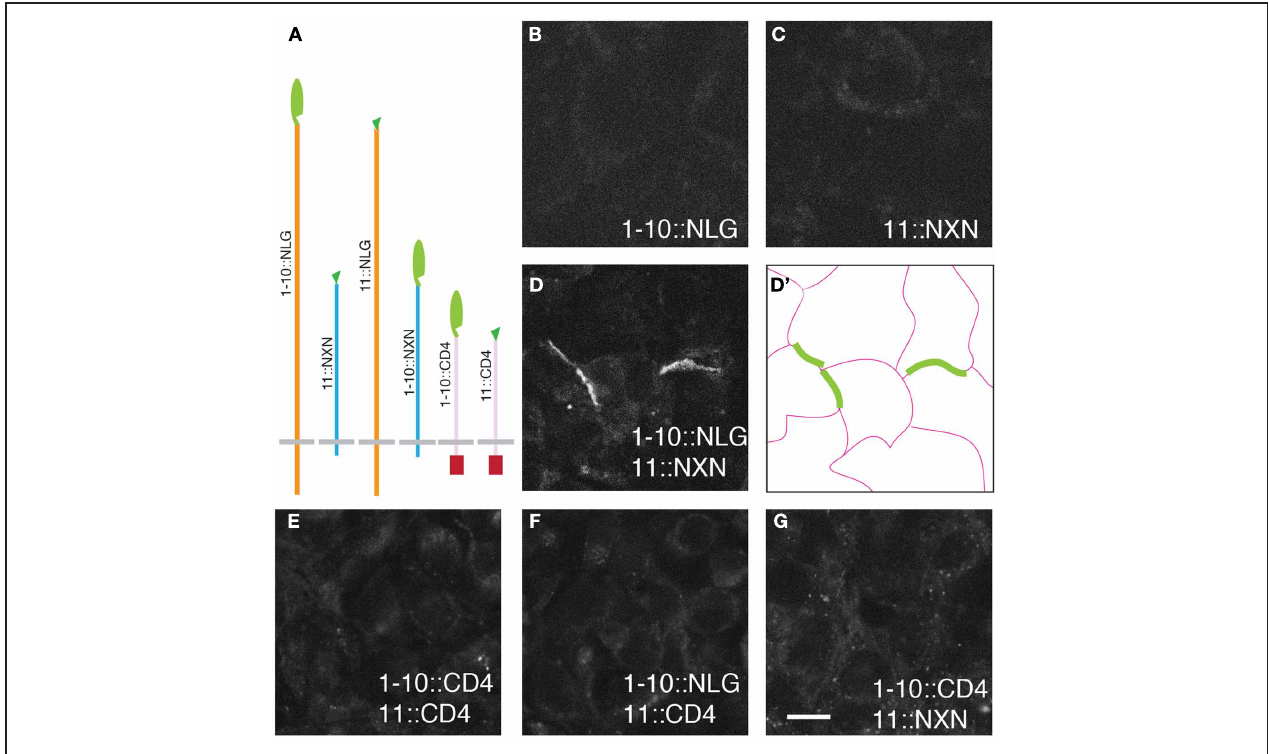
FIGURE 1 | GRASP signals in cultured mammalian cells. (A) Superfolder GFP fragments sGFP1–10 and sGFP11 were fused to mammalian transmembrane proteins neurexin (NXN), neuroligin (NLG), and CD4 for display on the cell surface. Assembly of sGFP1–10 with sGFP11 reconstitutes fluorescent GFP. (B–D) 293 cells stably transfected with